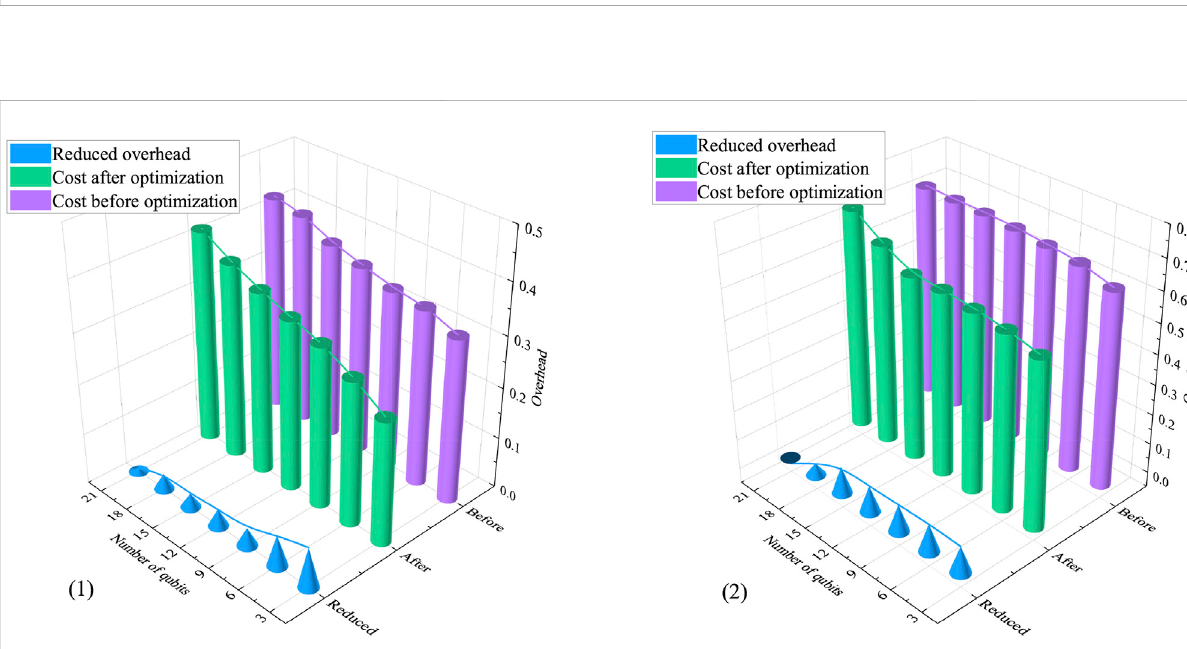
FIGURE 6 Quantumcircuitgateoverheaddatagraph.(1)Whenthethreshold p threshold =0.081574,theoriginalcostiscomparedwiththeoptimizedcostof the Q -network. (2)When the threshold p threshold = 0.09542, the original cost is compared with the optimized cost of the Q -network. Among them, theabscissa represents thenumberofqubits, which isdisplayedinscienti fi cnotation,and theordinate isthelogical cost. Theoriginalcostis marked in orange, and the Q -network optimized cost is marked in